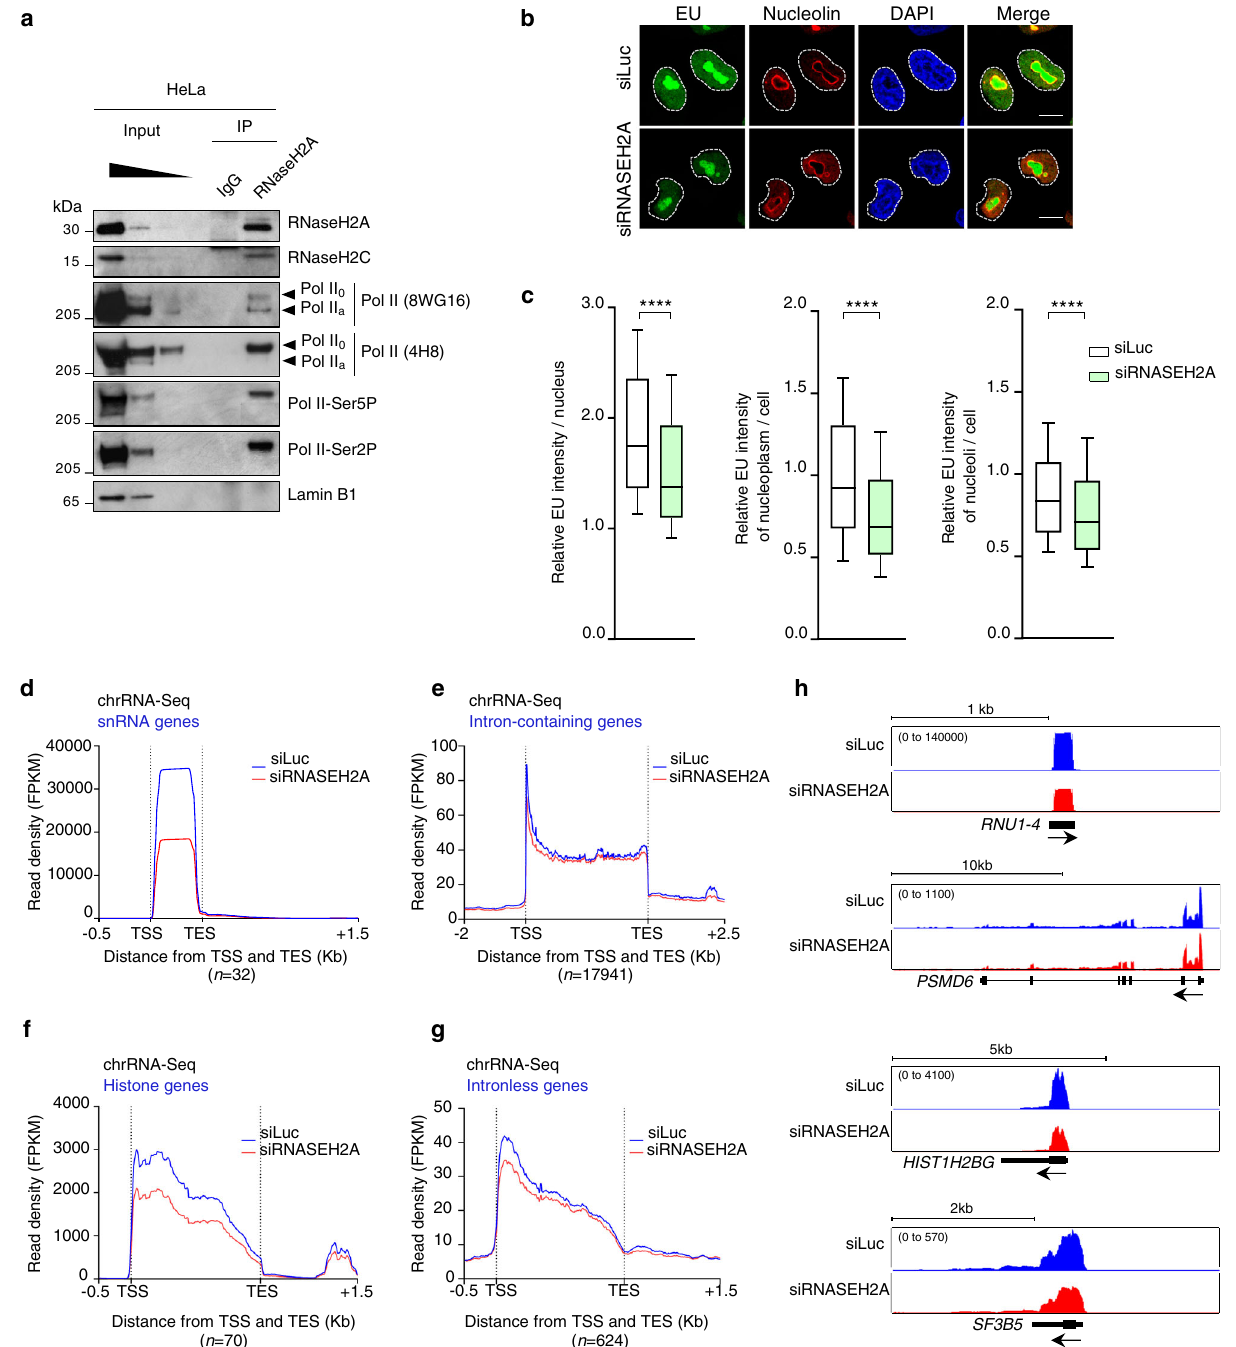
Fig. 3 RNase H2A depletion affects transcription. a Western blot of endogenous RNase H2A IP from HeLa WCE probed with the indicated antibodies. Arrows indicate hypo- (IIa) and hyper-phosphorylated (IIo) Pol II. IgG and Lamin B1 are negative controls. Representative blots from n = 2 biologically independent experiments. b IF analysis of EU incorporation in HeLa cells transfected with siLuc or siRNASEH2A. EU (green), nucleolin (red), DAPI (blue), Nucleolin + EU (merge); scale bars: 10 µ m. Representative images from n = 2 biologically independent experiments. c Quanti fi cation of EU intensity per nucleus (left panel), nucleoplasm/cell (nucleus without nucleolus; middle panel) or nucleoli/cell (right panel) in HeLa cells transfected with siLuc (white) or siRNASEH2A (green). EU intensity is normalized to the average nucleoplasmic intensity in siLuc condition. Boxplot settings are: box: 25 – 75 percentile range; whiskers: 10 – 90 percentile range; horizontal bars: median; outliers not displayed. >20,000 nuclei were quanti fi ed per condition. Representative data from n = 3 biologically independent experiments. **** p < 0.0001 (two-tailed unpaired t -test). d – g Meta-analysis for chrRNA-Seq on indicated categories of genes in HeLa cells following RNase H2A depletion with the window size of the presented plots adjusted to the gene size. siLuc (blue) and siRNASEH2A (red) tracks show the average signal of two replicates. h ChrRNA-seq pro fi les of RNU1-4 , PMSD6 , HIST1H2BG and SF3B5 genes in HeLa cells treated as in d – g . Source data are provided as a Source data fi